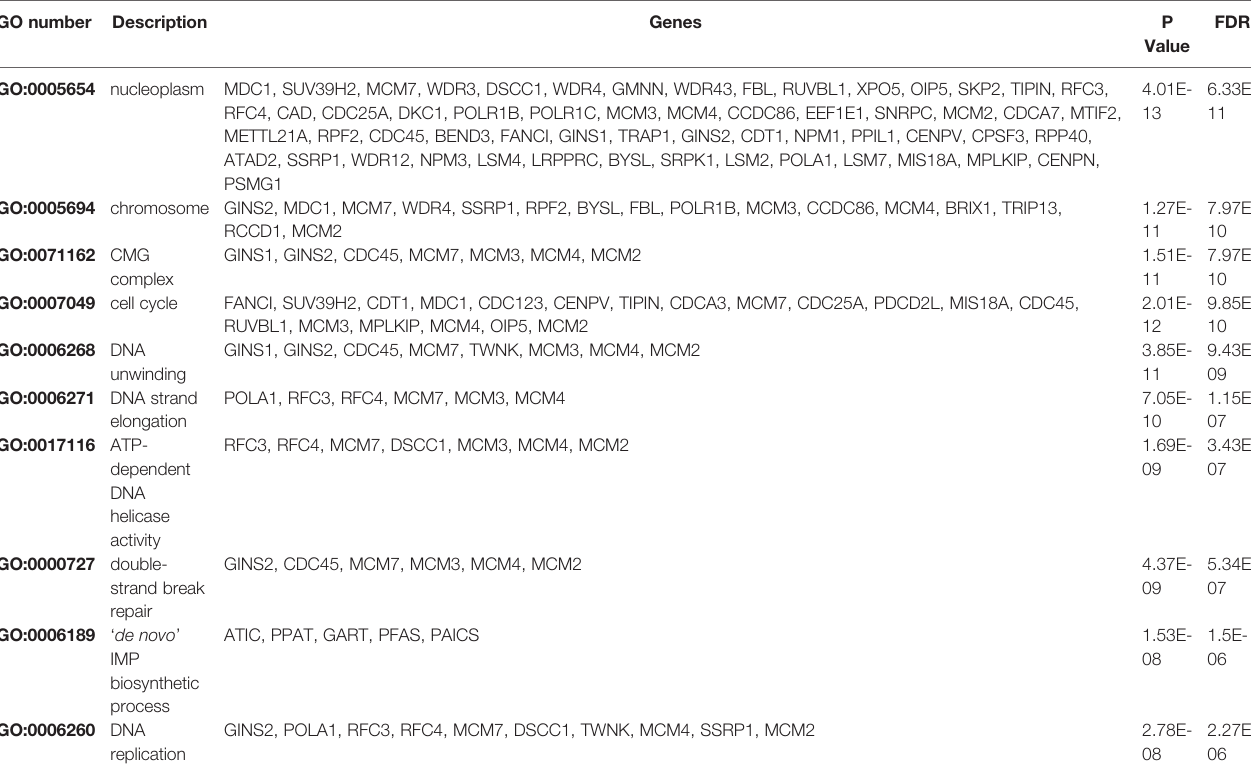
TABLE 3 | Gene ontology analysis of FOXP4-AS1-related genes. GO number Description Genes P